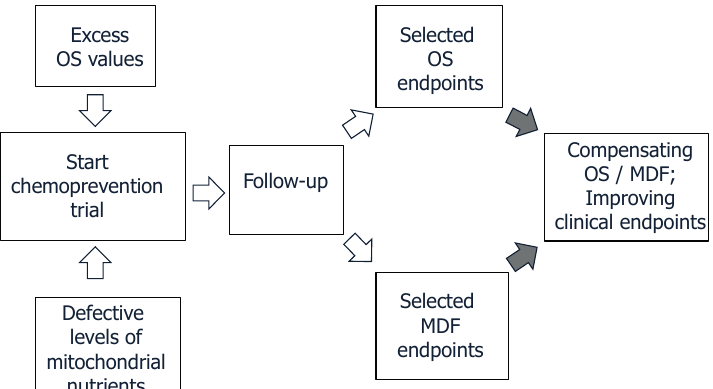
Figure 2. Follow-up procedures combining evaluation of MDF and OS endpoints, along with disease specific clinical